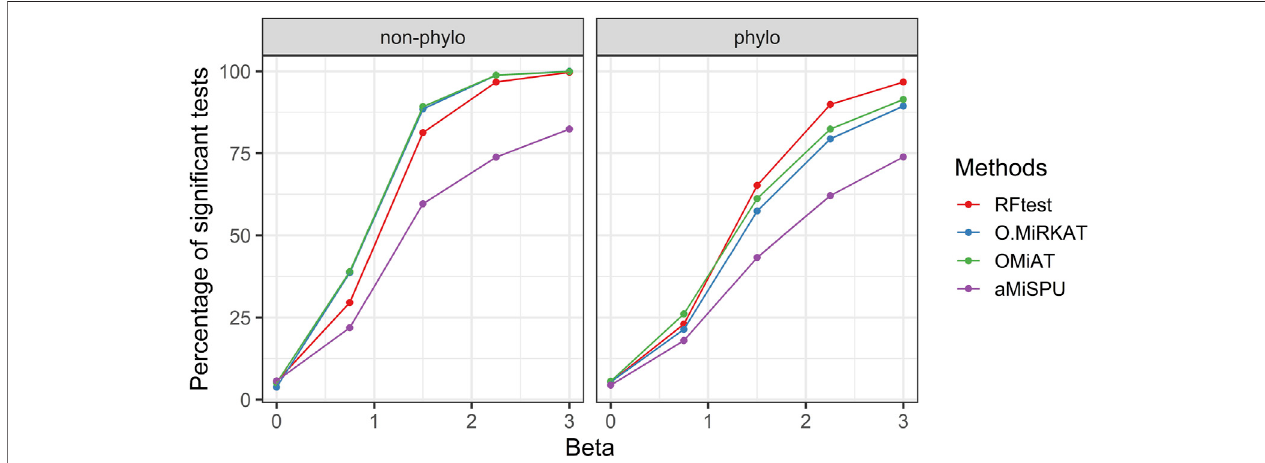
FIGURE3 | Power comparison among thecompeting methods fora binary outcome variable when X and Y arenon-linearly associated. The raw OTU abundance data were transformed using a link function of f log2 ( x ij ) (cid:1) log 2 ( x ij + 1) ( x ij ≥ 0). Two signal types, phylogenetic and non-phylogenetic, with a density of 15% were used.